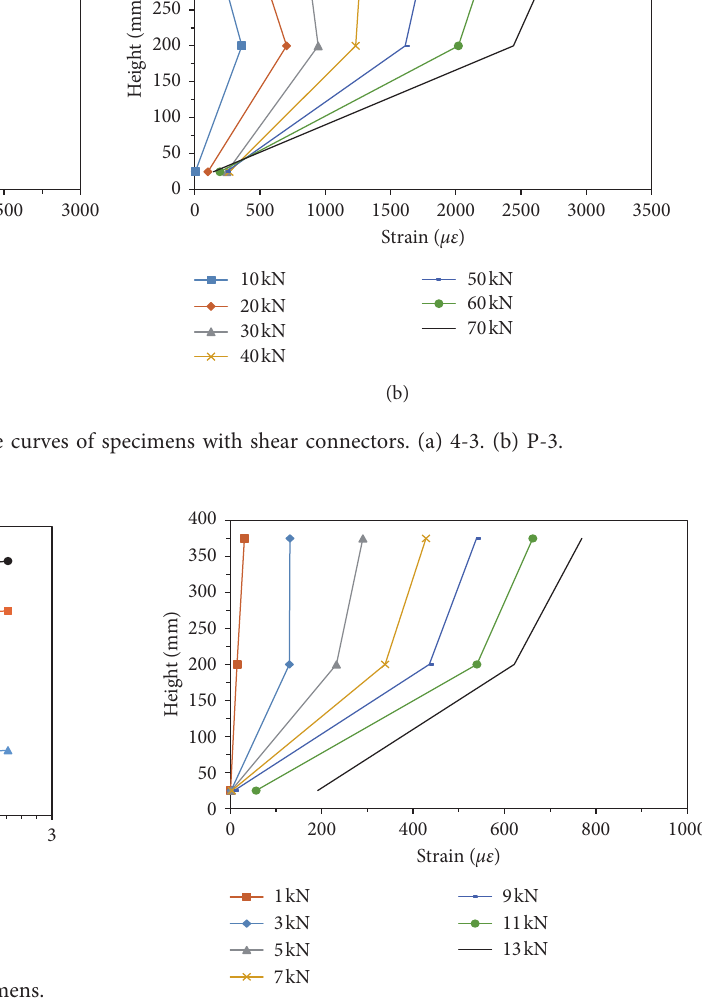
Figure 18: Strain-height curves of direct bond